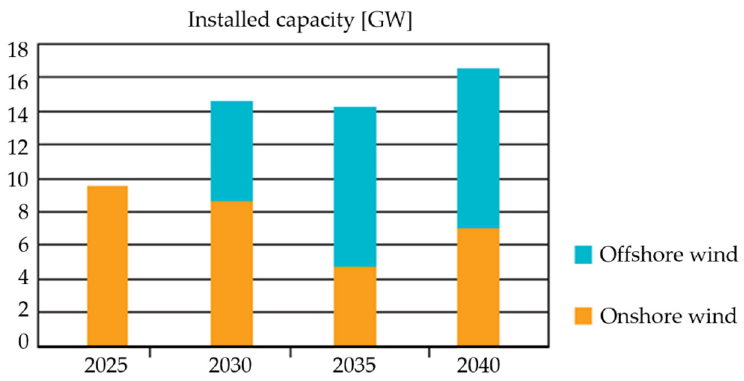
Figure 11. Wind Energy according to the PEP2040.